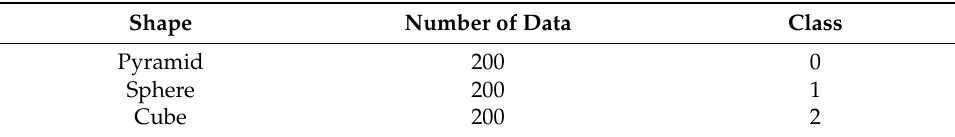
Table 1. Details of the dataset.